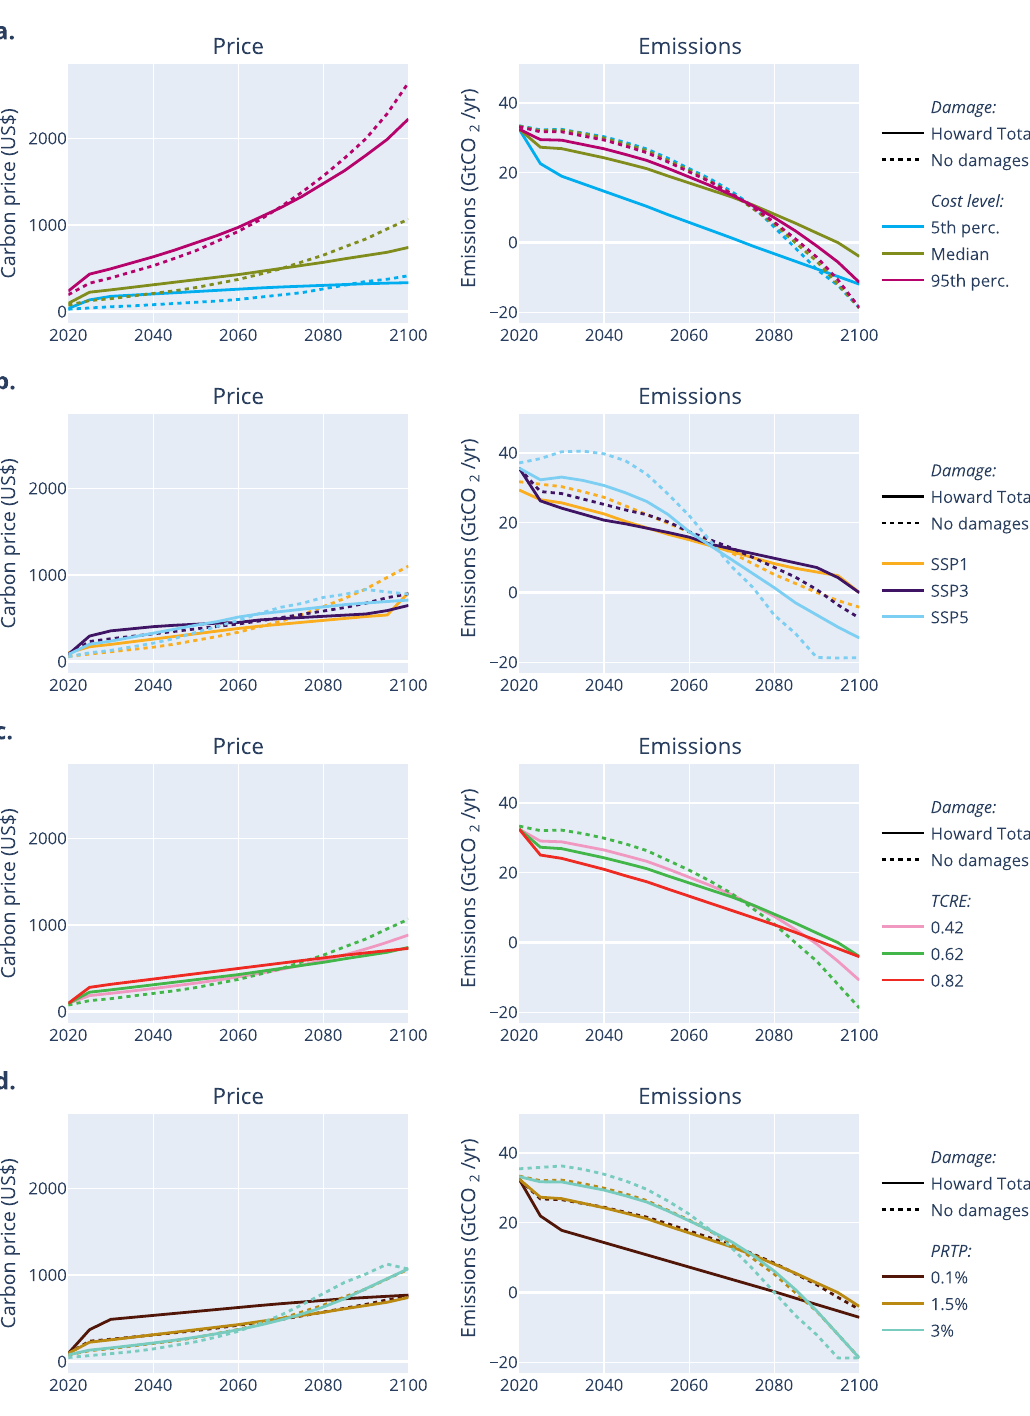
Fig. 2 Optimal carbon price paths (left) with corresponding emission path (right) for different scenarios with a 1344 GtCO 2 carbon budget (cost- minimising setting). For each scenario, the default parameters (see main text) are used, with one parameter changed ( a mitigation cost level, b SSP, c TCRE, d pure rate of time preference). The solid lines correspond to purely cost-minimising paths (no damages), the dotted lines take into account the medium damage function Howard